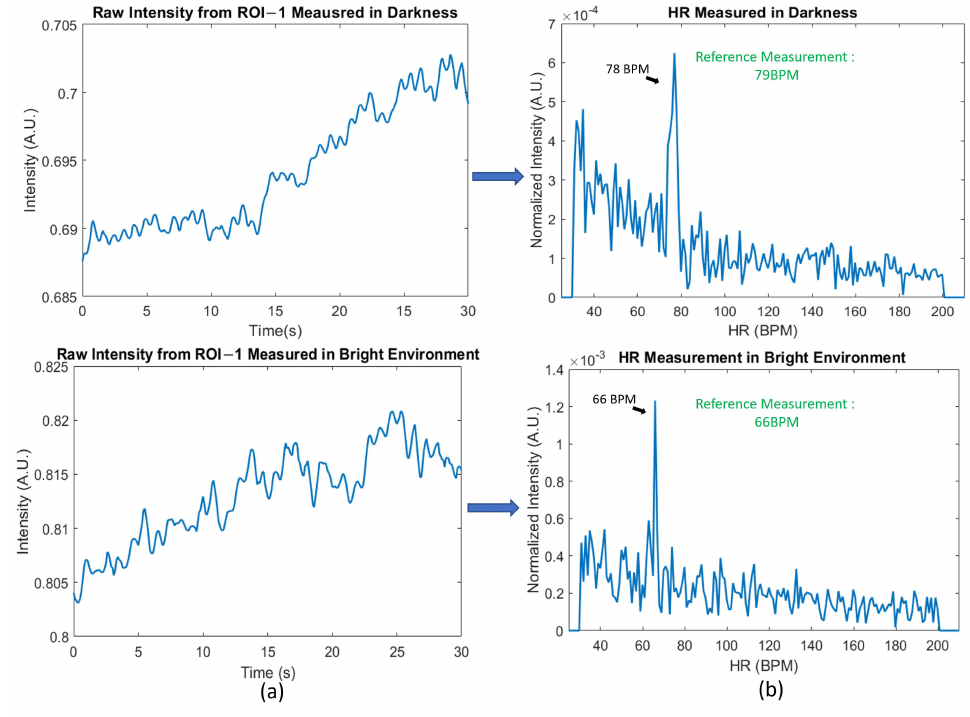
Figure 3. ( a ) Raw intensity signal from ROI-1 measured in dark/bright environment. The grayscale intensity shows a clear HR signal. ( b ) Frequency domain HR measured in dark/bright environment. The highest peak in the frequency domain correspond to measured